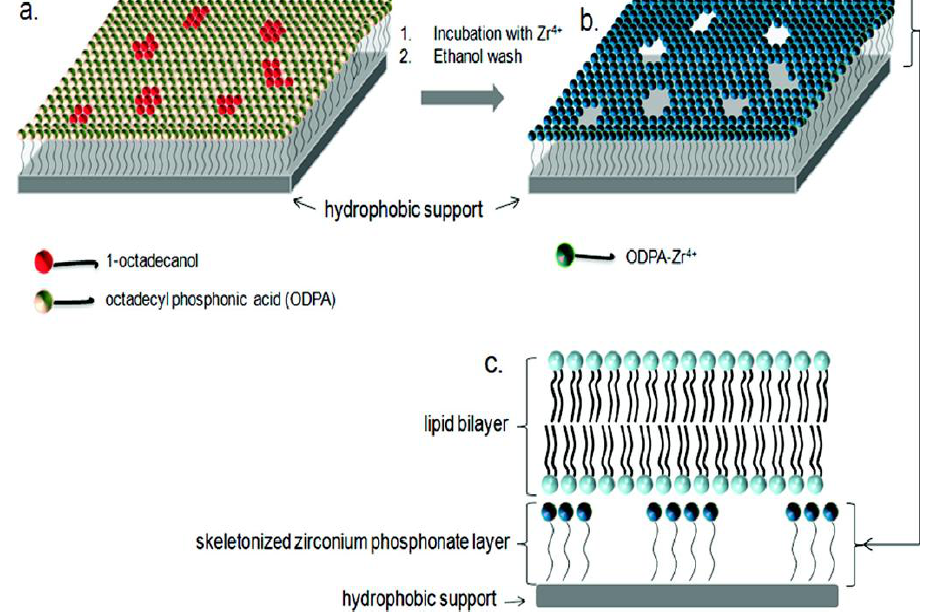
Figure 7. Supporting lipid bilayers with skeletonized zirconium phosphate surface ( a ) A mixed monolayer is on a hydrophobic surface; ( b ) the surface is washed with ethanol to skeletonized surfaces by vesicle fusion or by Langmuir-Blodgett/Langmuir-Schaefer techniques. Reprinted with permission from Langmuir [37]. (American